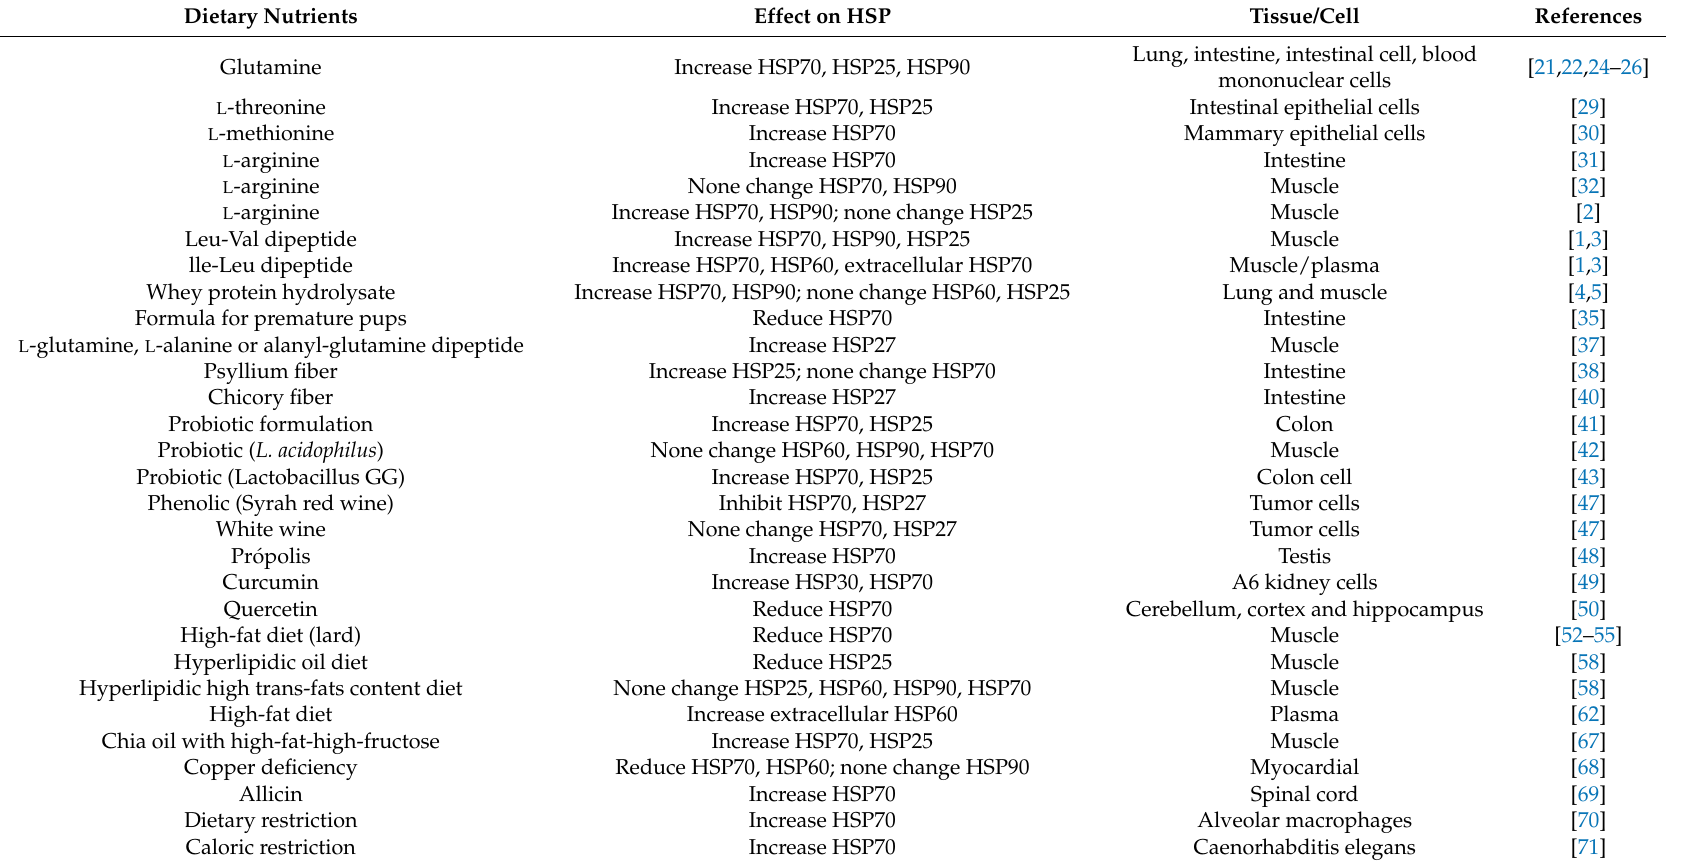
Table 1. Studies involving dietary components in the regulation of